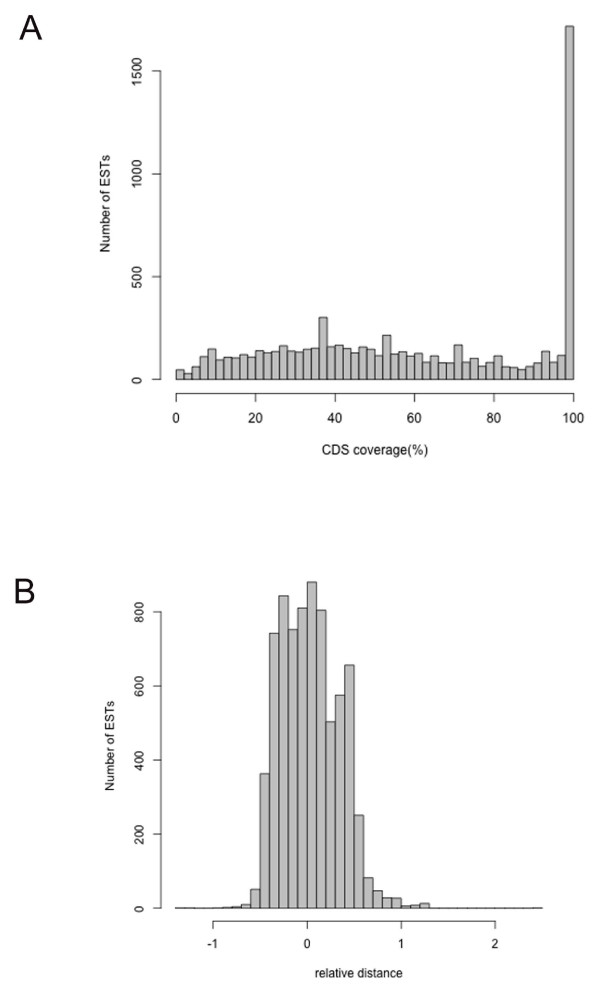
The distribution of the bear ESTs on CDS regions. (A) Distribution of CDS coverage among bear ESTs. About 1,600 bear ESTs contained full length CDS region. (B) Distribution of bear EST positions relative to the center of CDS region.